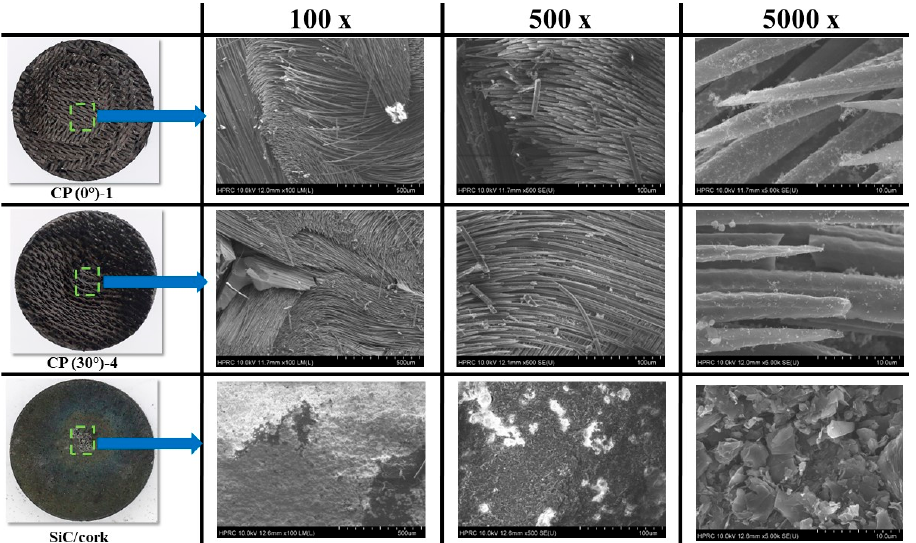
Figure 29. Specimen exposed surface SEM images.